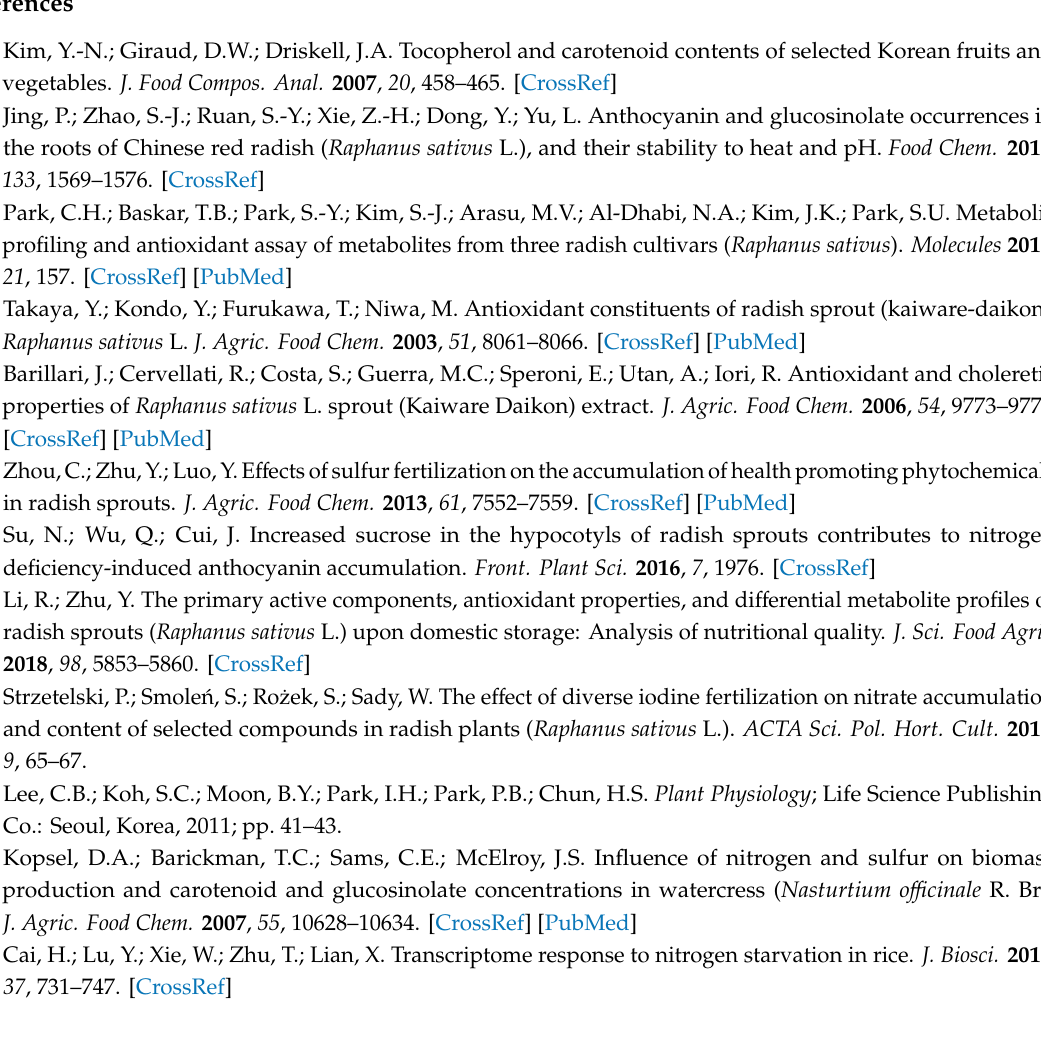
Figure S1: GC-TOFMS chromatogram of hydrophilic compounds in radish sprouts (0 DAI) grown under nitrogen su ffi cient condition; Figure S2: HPLC chromatogram of carotenoids in radish sprouts (0 DAI) grown under nitrogen su ffi cient condition; Figure S3: HPLC chromatogram of glucosinolates in radish sprouts (0 DAI) grown under nitrogen su ffi cient condition; Figure S4: Metabolite expression data mapped onto the schematic pathway of radish sprouts grown under (A) nitrogen su ffi cient and (B) nitrogen deficient conditions; Table S1: Phenotypic changes in radish sprouts during nitrogen deficient condition; Table S2: Composition and abundance of hydrophilic compounds in radish sprouts grown under nitrogen su ffi cient condition; Table S3: Composition and abundance of hydrophilic compounds in radish sprouts grown under nitrogen deficient condition; Table S4: Composition and abundance of policosanols, tocopherols, and phytosterols in radish sprouts grown under nitrogen su ffi cient condition; Table S5: Composition and abundance of policosanols, tocopherols, and phytosterols in radish sprouts grown under nitrogen deficient condition; Table S6: Composition and abundance of pigments in radish sprouts grown under nitrogen su ffi cient condition; Table S7: Composition and abundance of pigments in radish sprouts grown under nitrogen deficient condition; Table S8: Composition and abundance of glucosinolates in radish sprouts grown under nitrogen su ffi cient condition; Table S9: Composition and abundance of glucosinolates in radish sprouts grown under nitrogen deficient